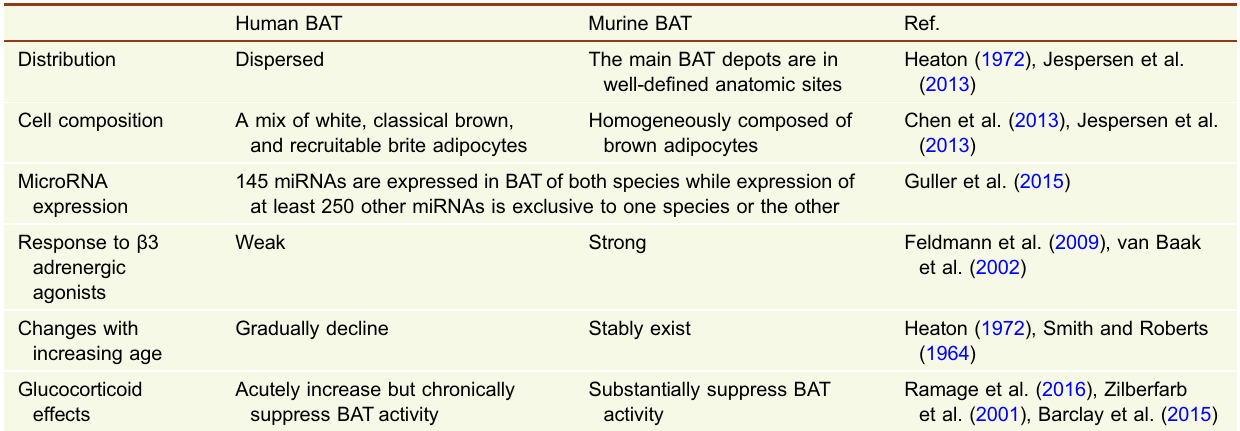
Table 2. Differences between human and mouse adipocytes Human BAT Murine